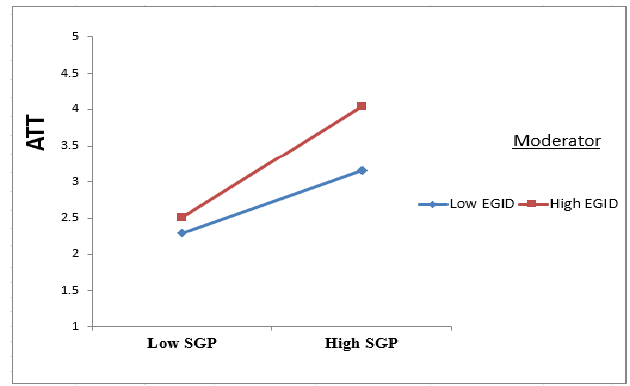
Figure 3. EGID moderation effect on SGP toward ATT.